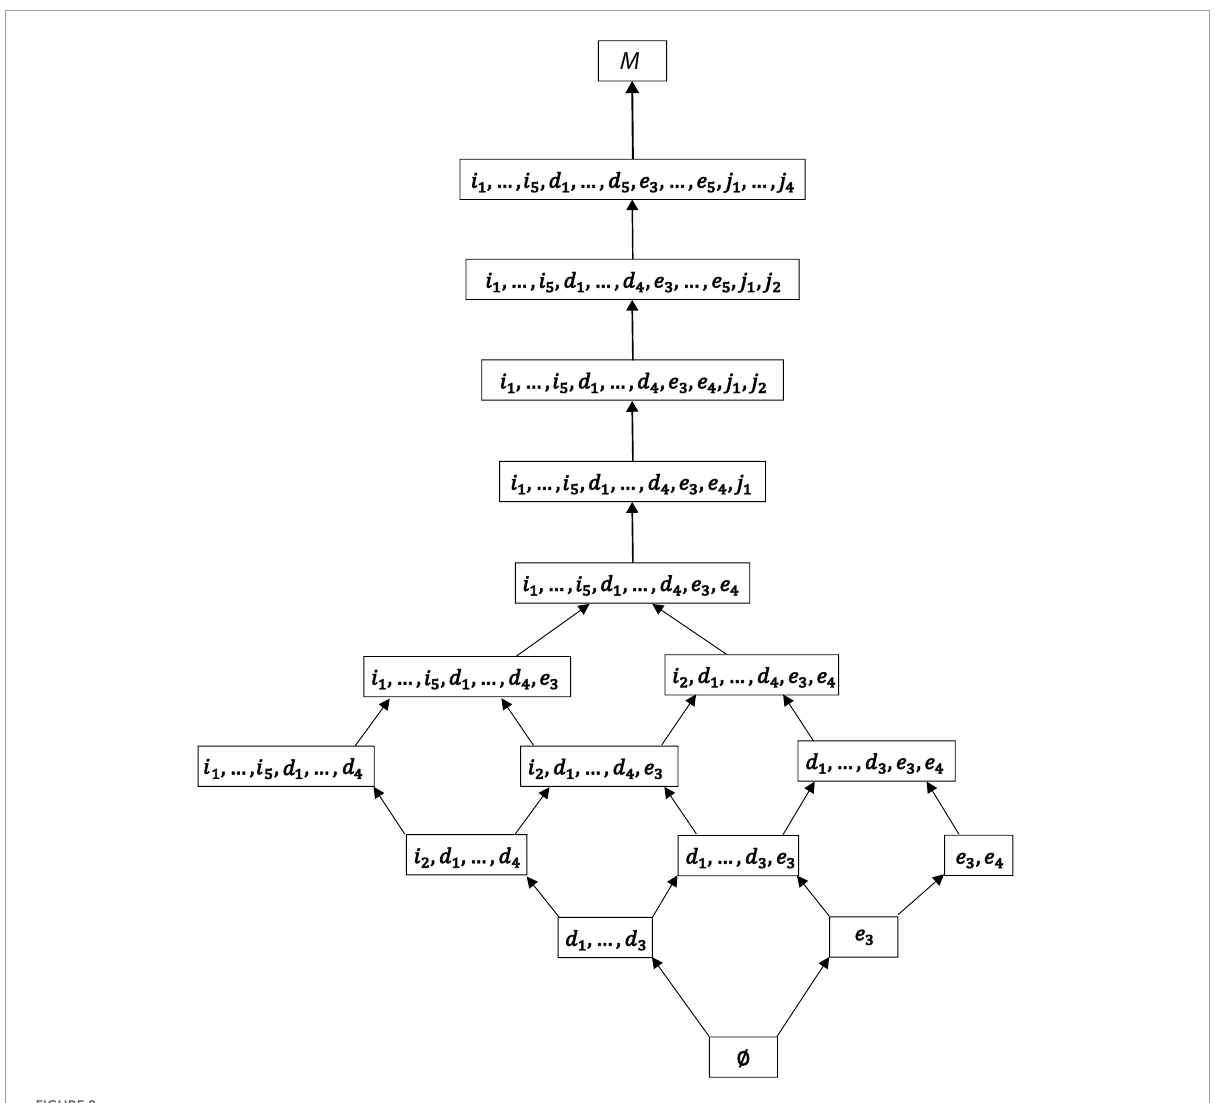
FIGURE8 The quasi-ordinal motivation space M f corresponding to the final IITA solution (cid:118) f . The graphical representation is read from bottom to top, where a sequence of arcs linking a motivation state to a state located top of it means that the former is a subset of the latter. The bottom part of the graph indicates a branched multidimensional structure, the top part a linear unidimensional ( “ mixed ”